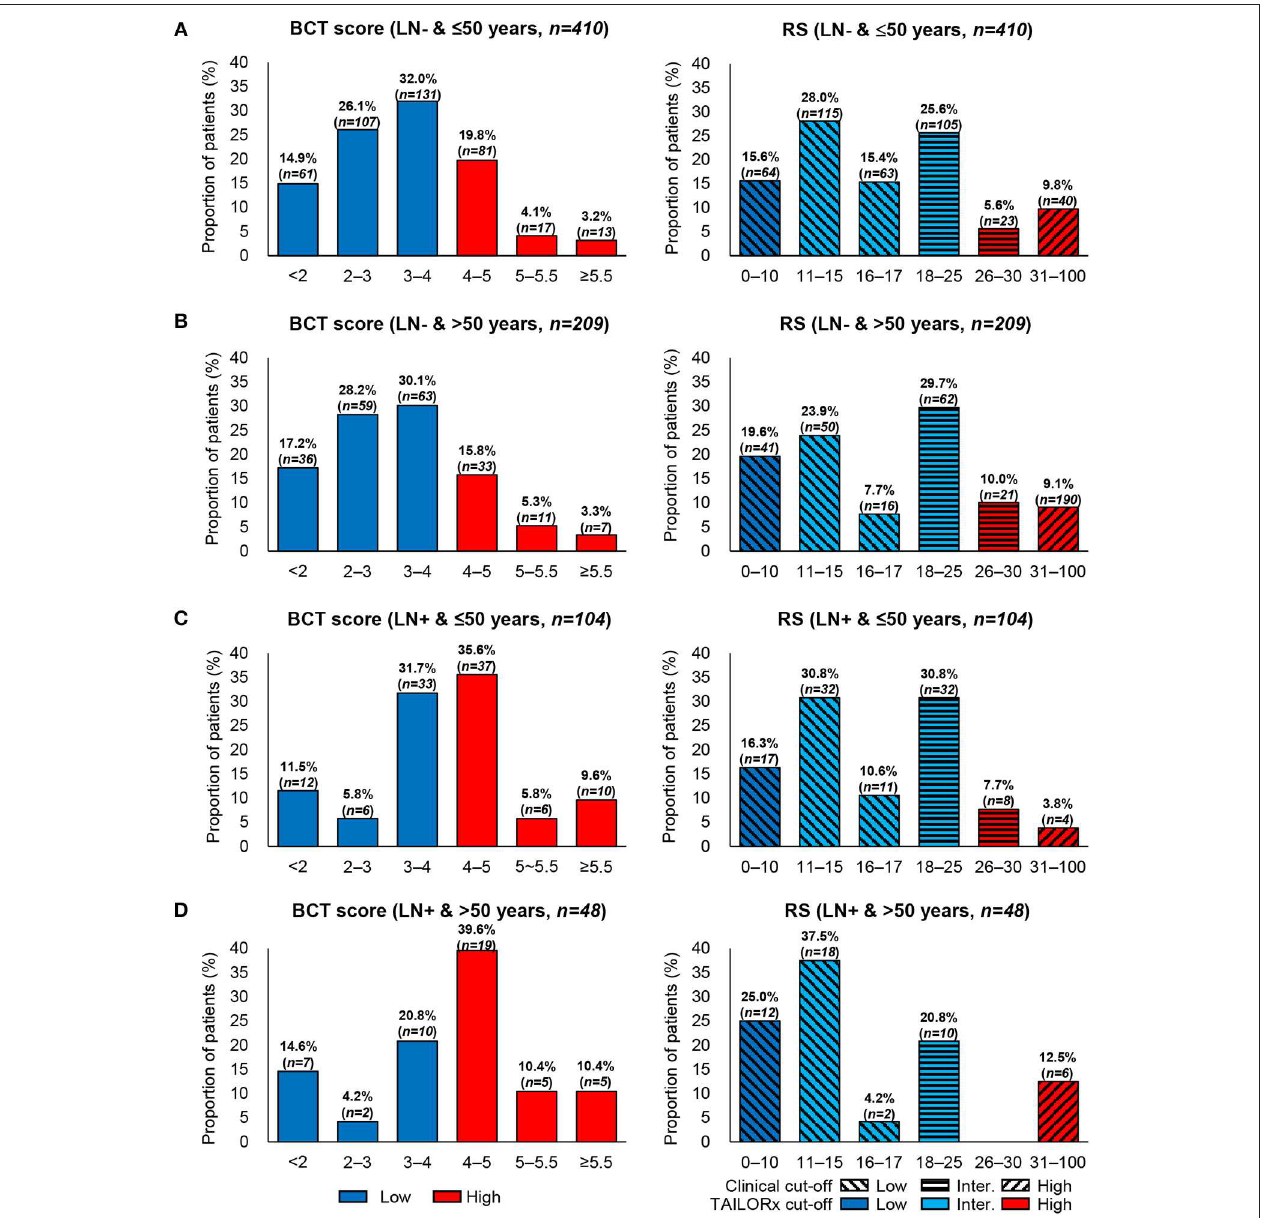
FIGURE 2 | Distribution of the BCT score and Oncotype DX RS by age within each nodal subgroup. Proportion of patients within each risk score range according to age and nodal status. (A) Patients aged ≤ 50 years with lymph node-negative (LN-) breast cancer ( n = 410). (B) Patients aged > 50 years with lymph node-negative (LN-) breast cancer ( n = 209). (C) Patients aged ≤ 50 years with lymph node-positive (LN + ) breast cancer ( n = 104). (D) Patients aged > 50 years with lymph node-positive (LN + ) breast cancer ( n = 48).